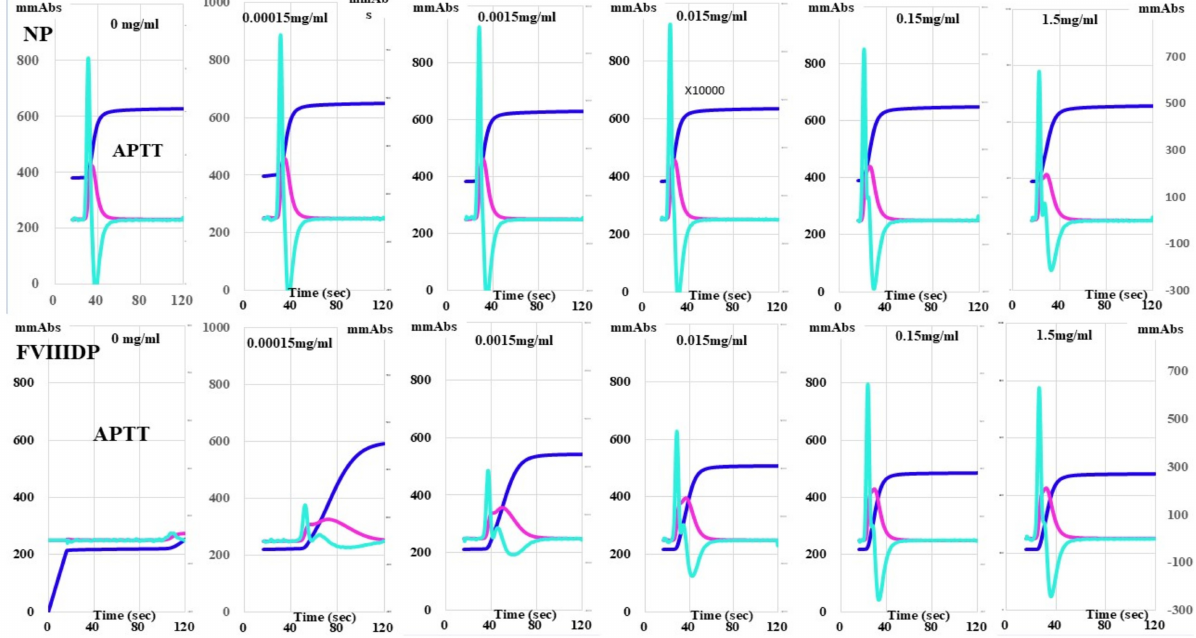
Figure 2. Effects of emicizumab on the clot waveform analysis (CWA)-activated partial thrombo- plastin time (APTT). Upper, NP (normal plasma); FVIIID, FVIII-deficient plasma; number mg/mL, emicizumab concentration; navy-blue, fibrin formation curve; pink curve, 1st derivative curve; light- blue curve, 2nd derivative curve. All assays were performed more than three times to confirm the